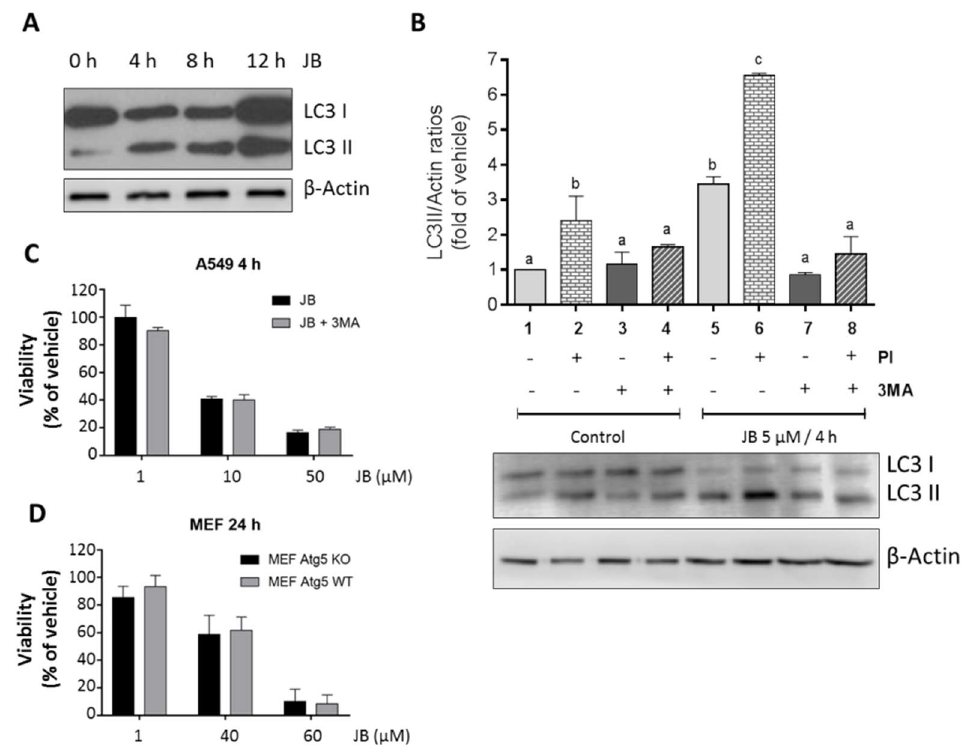
Figure 3. Analysis of autophagy induced by Jaspine B (JB) in A549 cells. ( A ) Analysis of microtubule- associated protein 1 light chain II (LC3II) expression by Western blot in A549 cells treated with JB 5 µM at different times for up to 12 h. ( B ) Analysis of LC3II expression by Western blot in A549 cells pretreated or not for 2 h with protease inhibitors (PI) (10 µg/mL E-64-D and 5 µg/mL pepstatin A) and/or for 0.5 h with 5 mM 3-methyladenine (3MA) and then treated with JB (5 µM, 4 h) or vehicle (0.05% EtOH). Results are representative of three experiments. ( C ) Determination of cell viability with 3-(4,5-dimethylthiazol- 2-yl)-2,5-diphenyl tetrazolium bromide (MTT) in A549 preincubated or not with 5 mM 3-methyladenine for 0.5 h and treated with JB at different concentrations for 4 h. Results are the mean ± SD of two experiments in triplicate. ( D ) Determination of cell viability by MTT assay in autophagy-related gene 5 (Atg5) −/− (Atg5 KO) and Atg5 +/+ (Atg5 WT) mouse embryonic fibroblasts (MEF) incubated with different concentrations of JB for 24 h. Data (+/-SD) correspond to three experiments in triplicate.